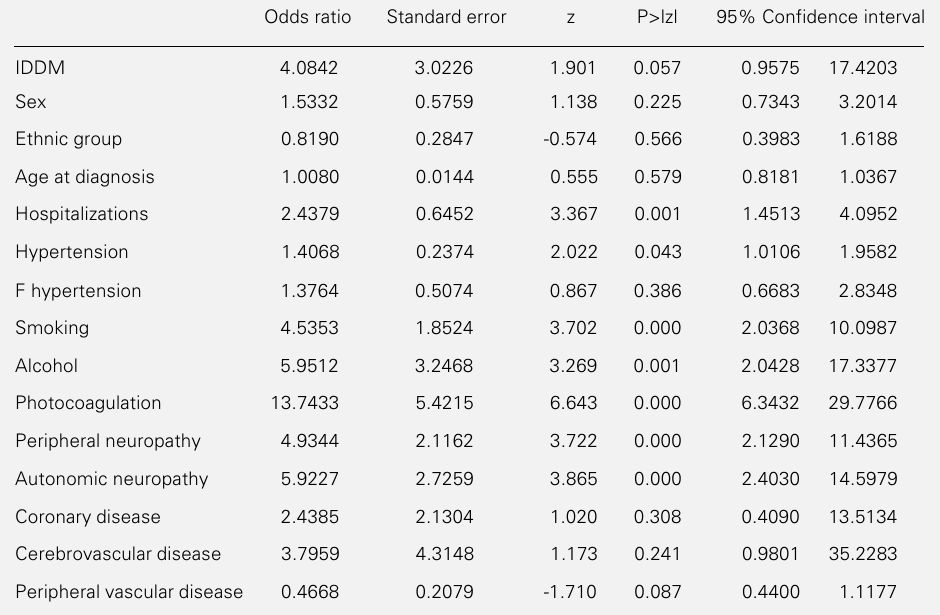
Table 3 - Results of logistic regression